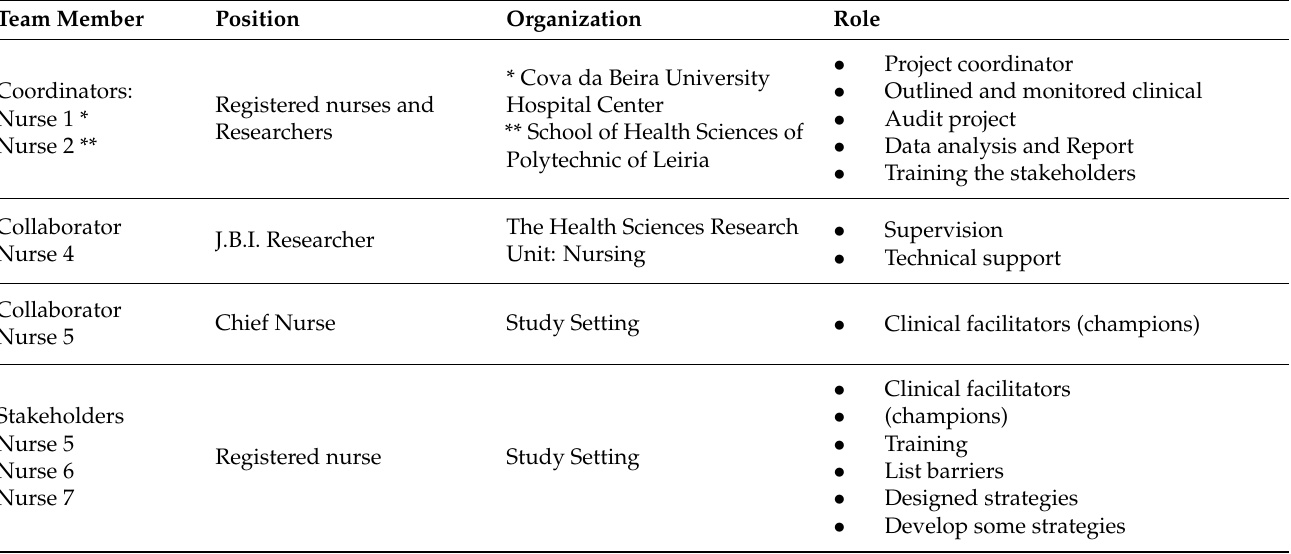
Table 1. Team members, their positions, organizations and roles in the implementation project.